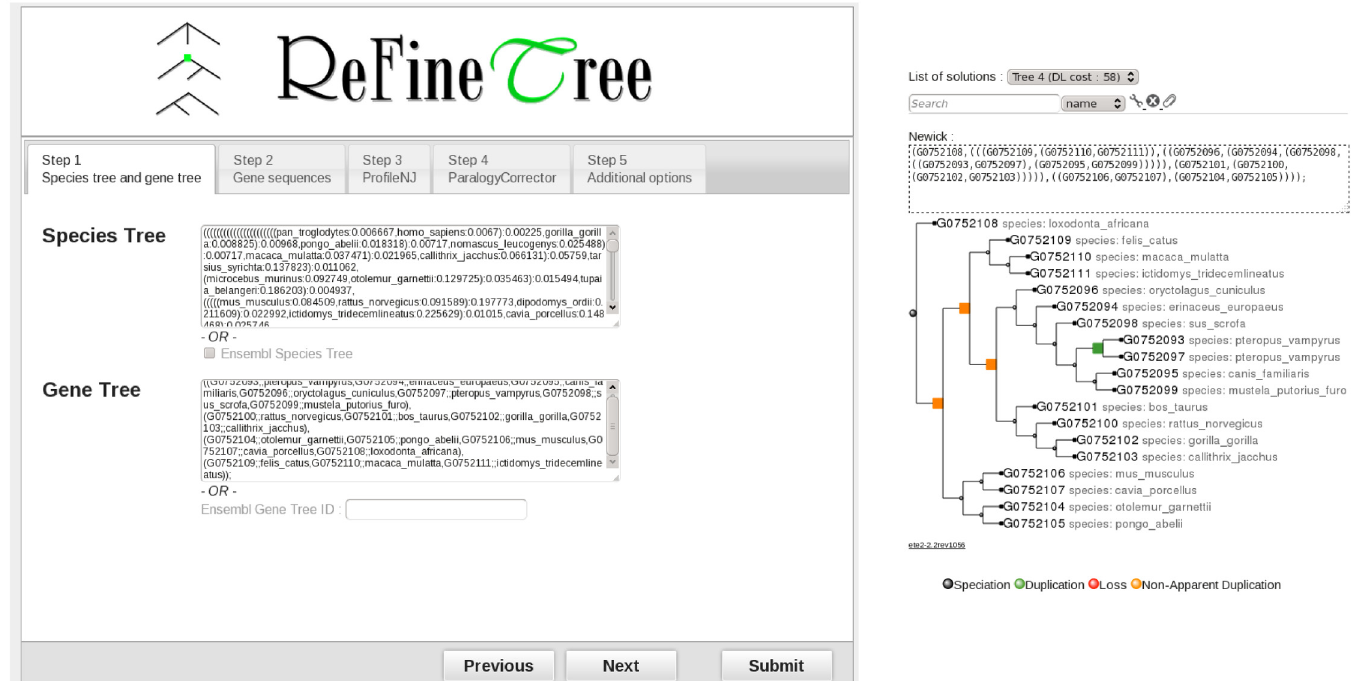
Fig 4. RefineTree web interface. The input is a species tree (or by default the Ensembl species tree) and a gene tree (or an Ensembl gene tree ID), gene sequences and additional options such as the branch contraction threshold, the request to test all roots, the maximum number of trees to be output by ProfileNJ and sorted by likelihood, etc. The integrated algorithms are ProfileNJ and ParalogyCorrector. Using this second algorithm requires, in addition, the input of a set of orthology